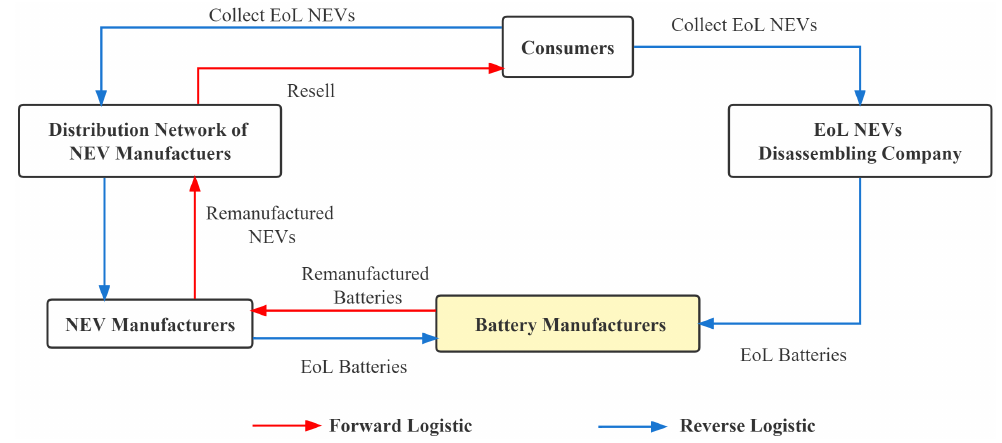
Figure 4. Battery manufacturer recycling model.